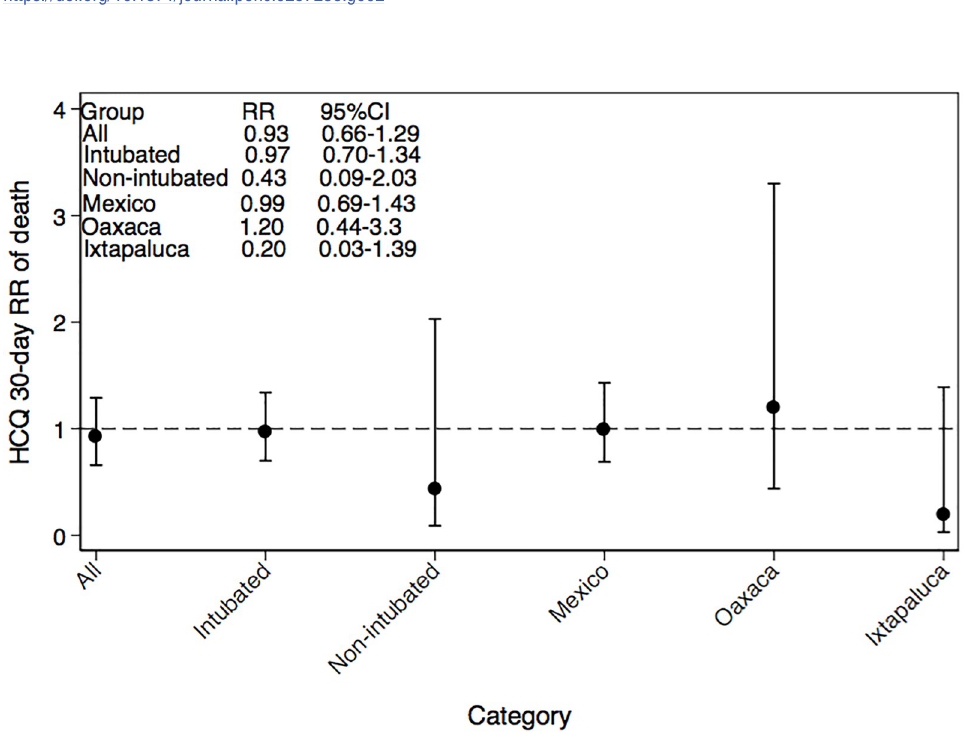
Fig 3. Impact of HCQ in the non-adjusted relative risk of death at 30 days. Stratified by the presence of invasive mechanical ventilation and by the site of recruitment.